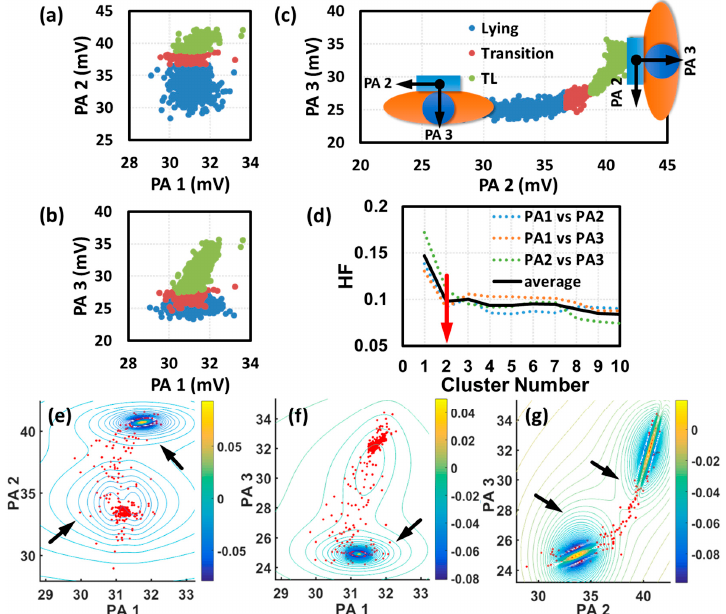
Figure 4. Estimation of a Lying-to-TL case using the proposed DDFM algorithm. From ( a – c ), the scattered plots show the mapped results of the time signals in their corresponding physical spaces. Meanwhile, the classified results are also exhibited, as well as their corresponding specific states of motional patterns. There are three states in this case: lying, transition, and TL. The most probable cluster number is indicated by the trend curve of the global Hamiltonian functional, as illustrated in ( d ). The cluster number was assigned as prior information for constructing the LDF morphologies, as shown from ( e – g ), and the corresponding cluster boundaries can be defined by finding the lowest energy levels that only enclose one cluster center. The corresponding cluster boundaries have been indicated by the black arrows in the plots.